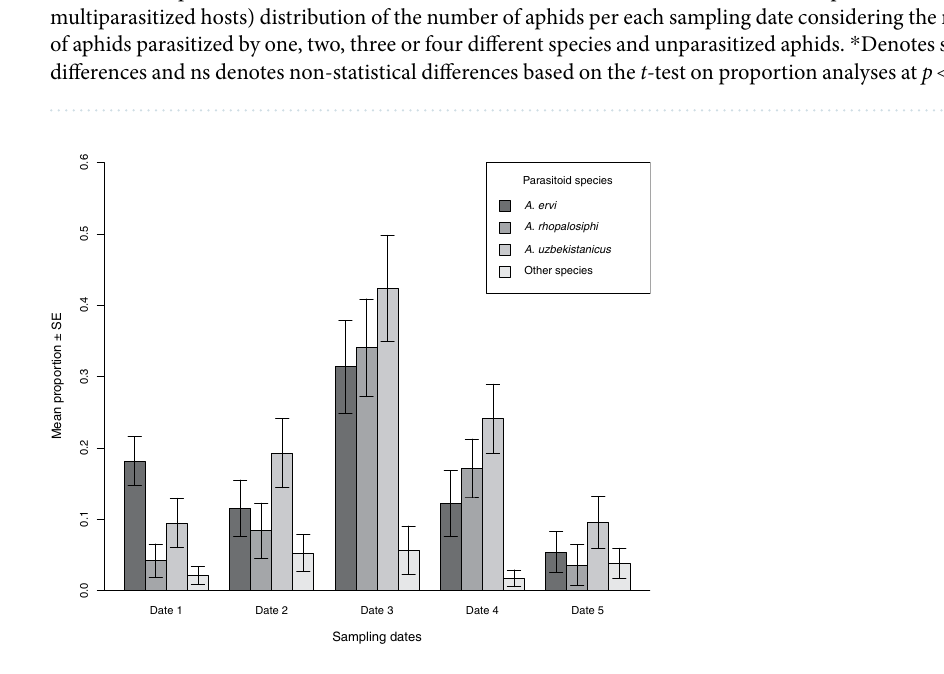
Figure 4. Mean proportion of detected parasitoid species ( ± standard error (SE)) per field per each sampling date by the molecular approach. Different bars represent different parasitoid species. Proportions per parasitoid species were calculated on the total number of aphids sampled per field and per date. In the screened samples, each aphid could be parasitized by one to four different parasitoid species (see Table 1 for